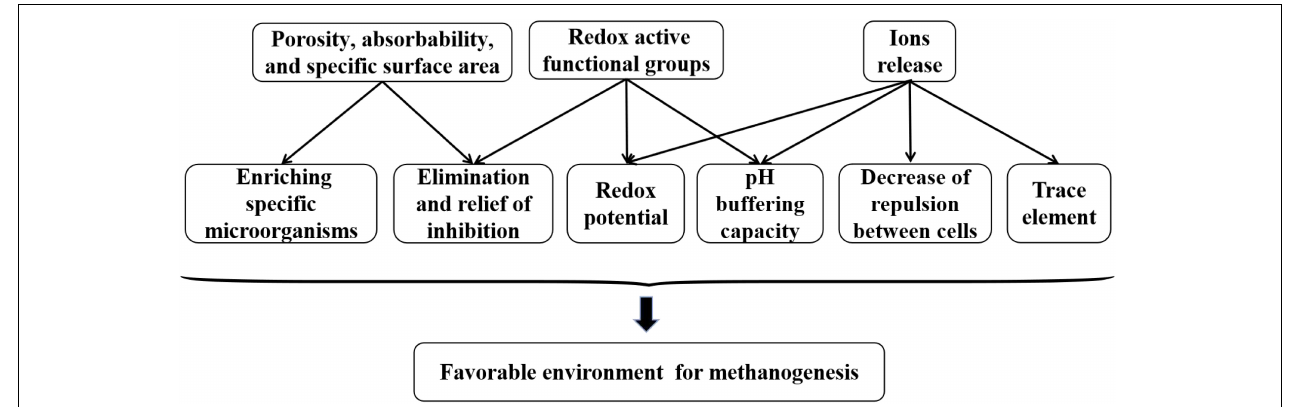
FIGURE 4 | Enhancement effects of non-DIET